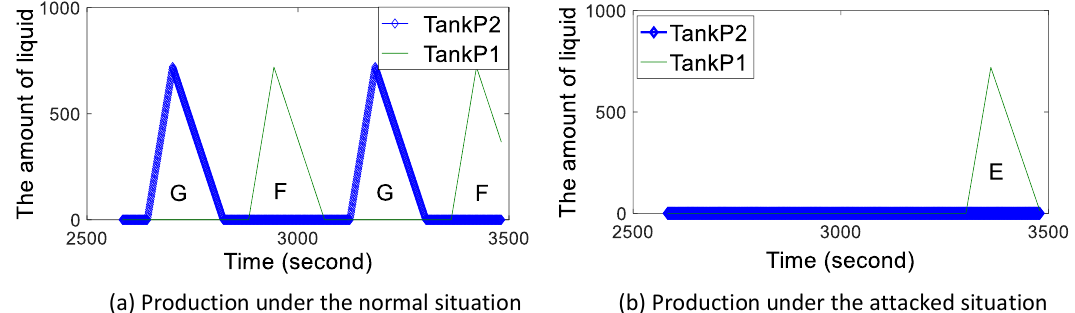
Figure 9. Production under the normal situation and the attacked